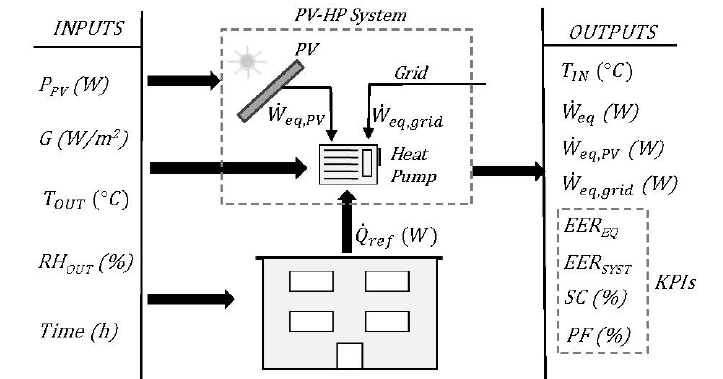
Figure 3. Schematic representation of the interaction